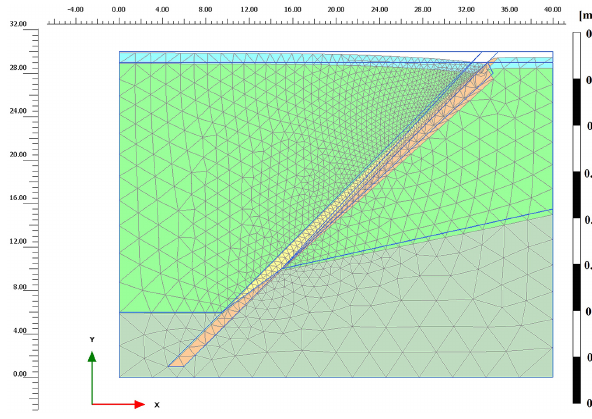
Figure 6. Maximum total horizontal displacement after water ex- traction.